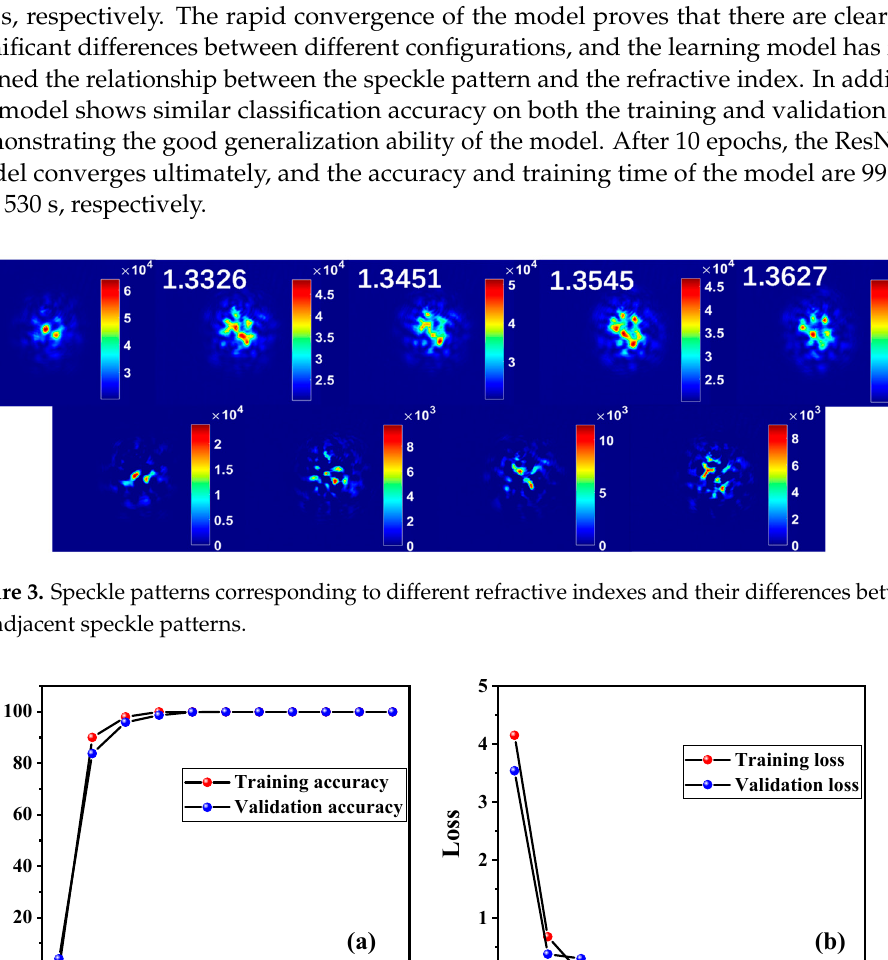
Figure 4. Learning curve of model based on ResNet18 architecture: (a) The training accuracy is plotted as a function of epochs. (b) The relationship between loss and epochs.